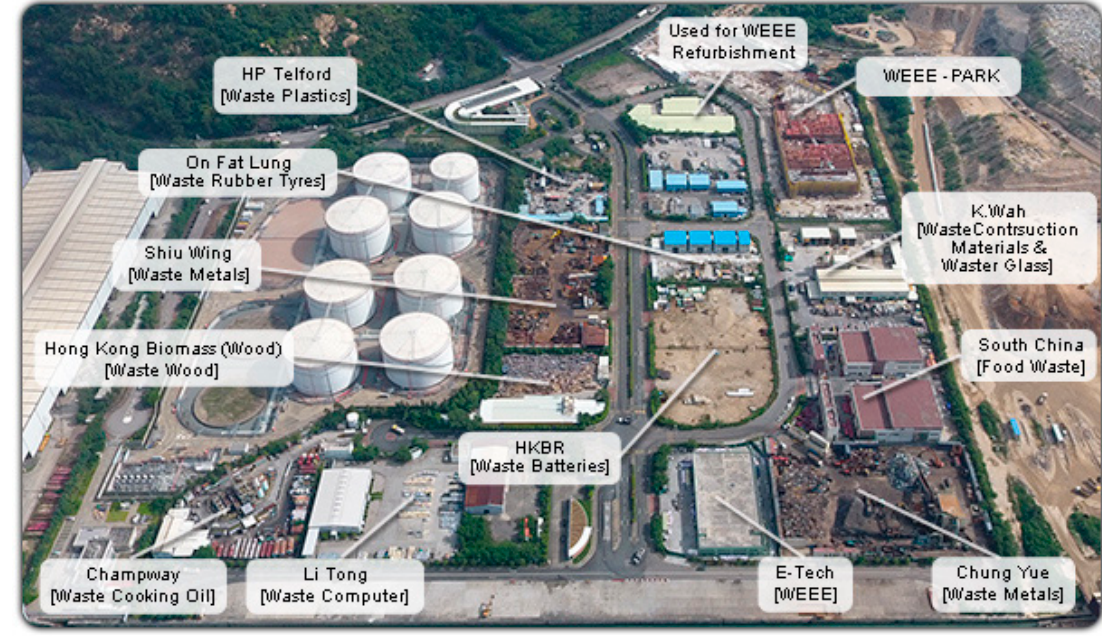
Figure 5. Eco Park, Hong Kong [35].